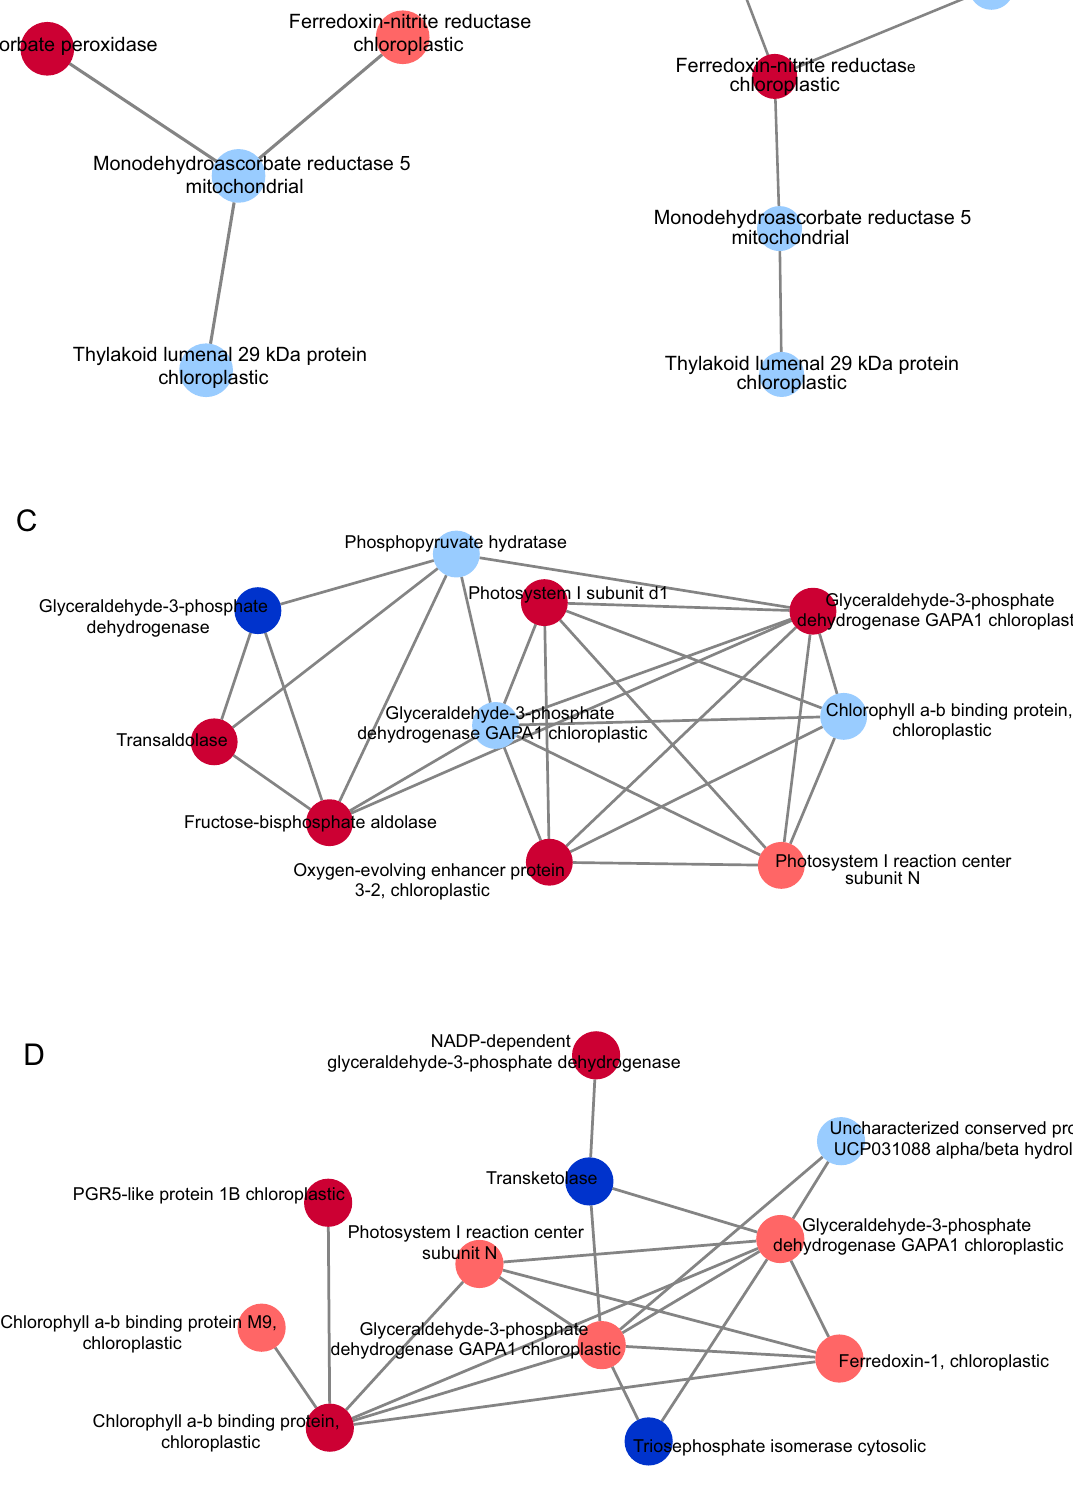
Figure 4. Protein–protein interaction (PPI) network between DAPs and their role in NUE. Only first neighbors are shown in the interactions. The light and dark blue ellipses represent unique proteins at low N-level and downregulated proteins, respectively. The light and dark red ellipses represent unique proteins at high N-level and upregulated proteins, respectively. ( A , C ) PPI network from the P2 inbred line; ( B , D ) PPI network from the L80 inbred line. The first degree of interaction was retrieved from STRING (version 10.5) using a minimum required interaction score of 0.7, and the network analysis performed in Cytoscape (version